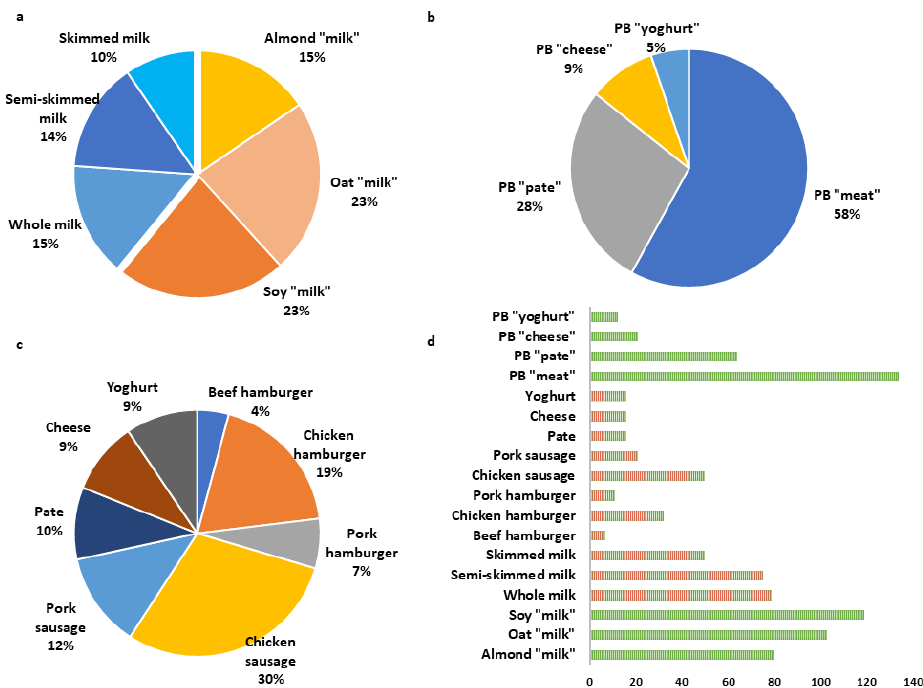
Figure 1. Proportion of plant-based (PB) foods and non-plant-based foods, i.e., AB foods, that were included in this study: ( a ) group of beverages including PB “milk alternatives” (almond, oat, and soy “milk”) and AB milk items (whole cow milk, semi -skimmed, and skimmed milk); ( b ) PB foods without PB “milk alternatives”; ( c ) AB foods without milks; ( d ) number of items of all food prod- ucts considering both PB (in green colour) and AB foods (in orange colour).